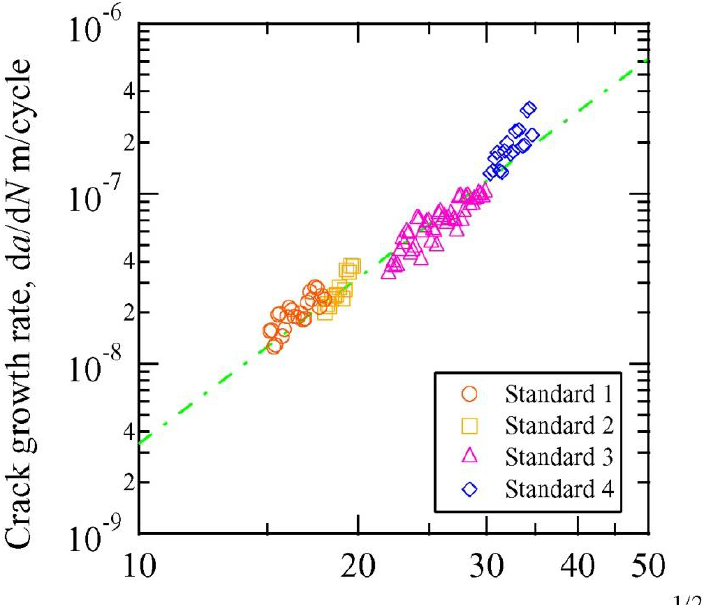
Figure 8. Fatigue crack growth rate as a function of stress intensity range for CT control samples without the application of